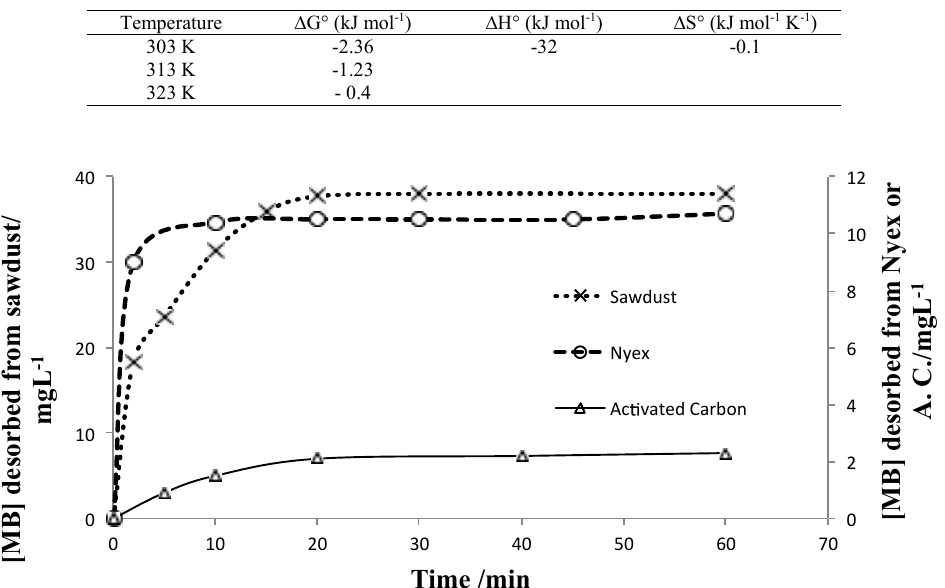
Fig. 3: Desorption kinetics of MB from sawdust, Nyex® and Activated Carbon at 303 K. Operating conditions : 1 g of saturated sawdust or A.C. and 16 g of Nyex®, V=200 mL, [Na 2 SO 4 ]= 0.1 mol/L, T=303 K.